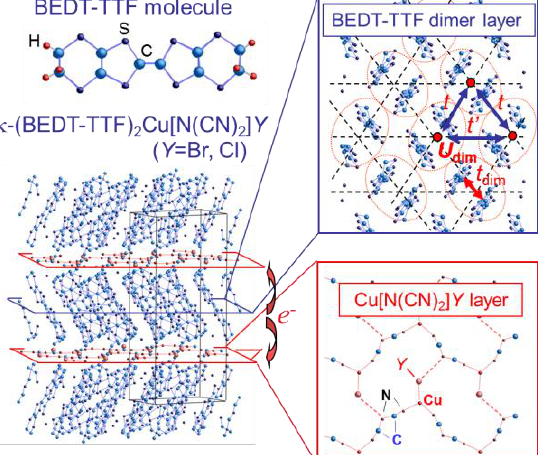
Figure 1. Crystal structure of κ-(BEDT-TTF) two-dimensional conduction plane consists of bis(ethylenedithio)-tetrathiafulvalene (BEDT-TTF) molecule dimers, which form an anisotropic triangular lattice. The anisotropy is defined by the ratio of the interdimer transfer energies t and t ′. The degree of electron correlations is determined by the ratio of on-site (dimer) Coulomb energy U bandwidth W (~4 t